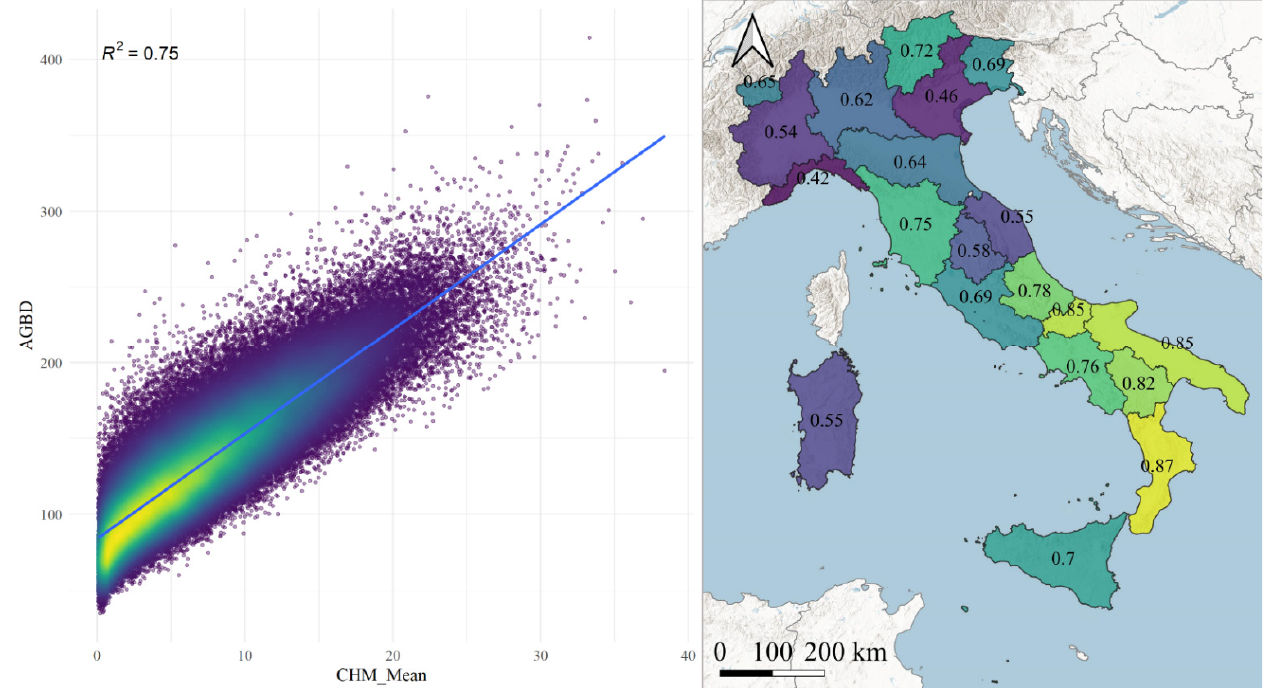
Figure 3. Left—scatter plot of aggregated AGBD and CHM with the blue line showing the linear correlation. Right—a map indicating the different correlations for each Italian region.